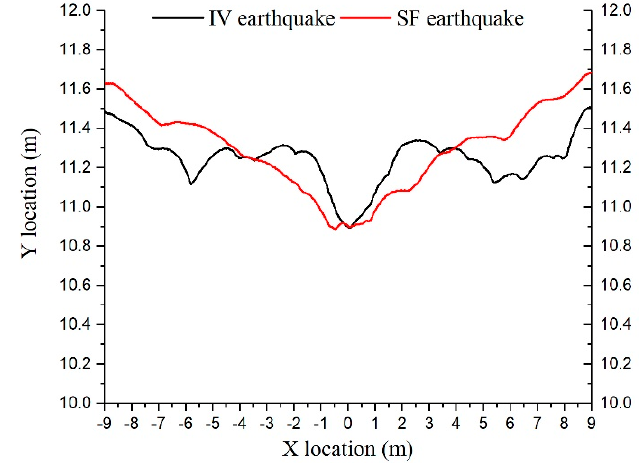
Figure 11. The maximum free surface envelope under two different ground motions.